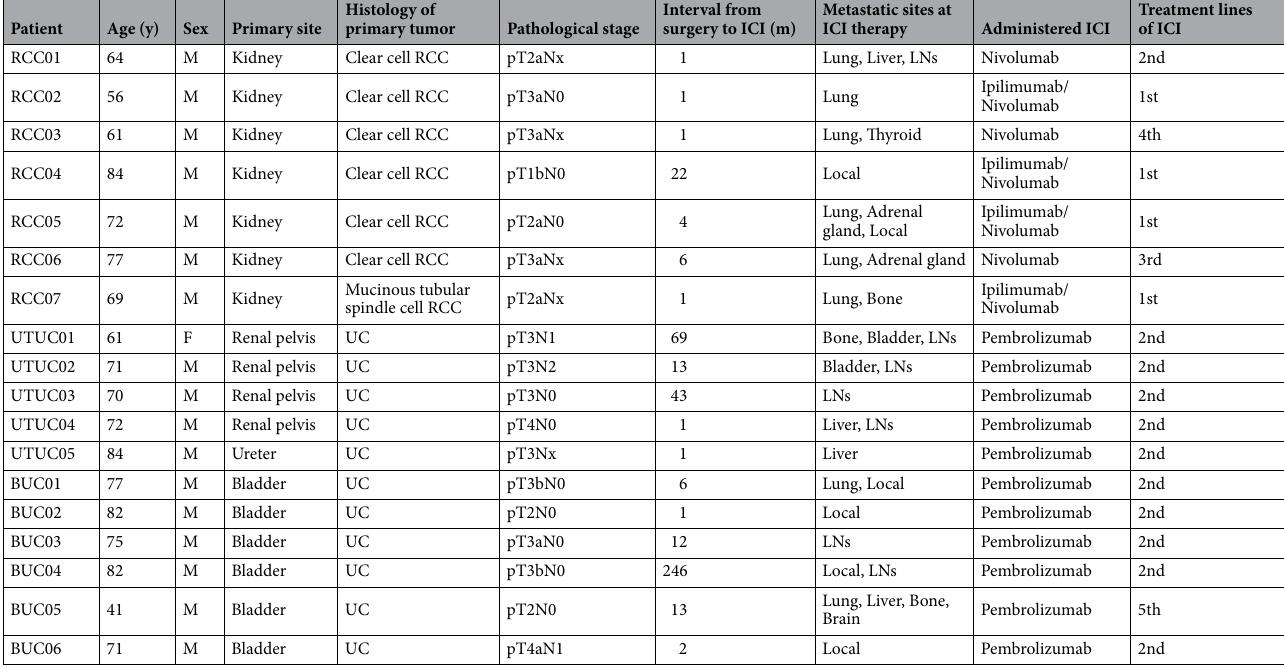
Table 1. Patient’s characteristics. RCC, renal cell carcinoma; UTUC, upper tract urothelial carcinoma; BUC, bladder urothelial carcinoma; ICI, immune checkpoint inhibitor, m, months; LNs, lymph